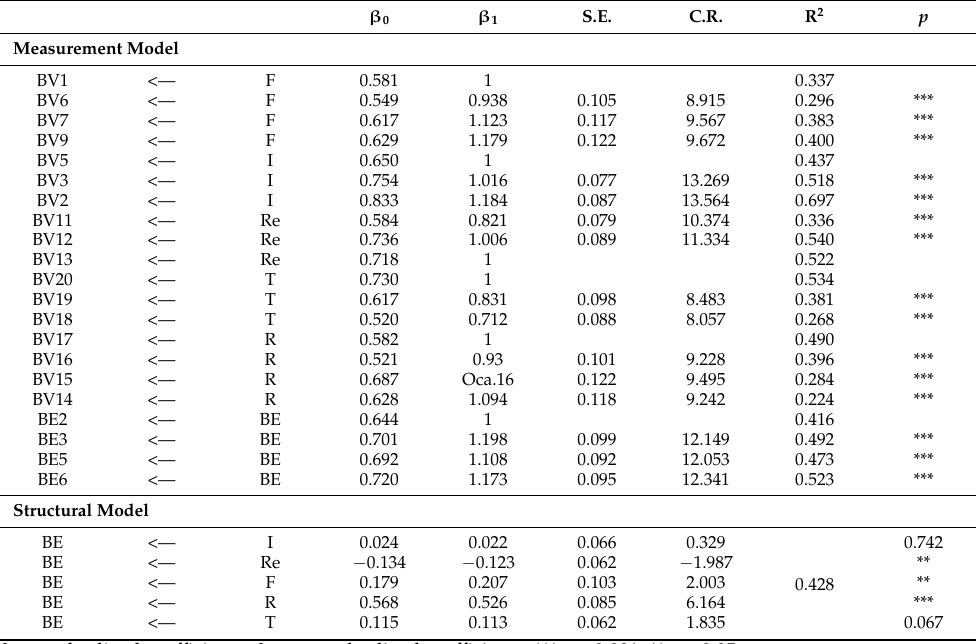
Table 7. Standardized and unstandardized versions of the obtained path coefficients (Source: authors’ compilation) . β 0 β